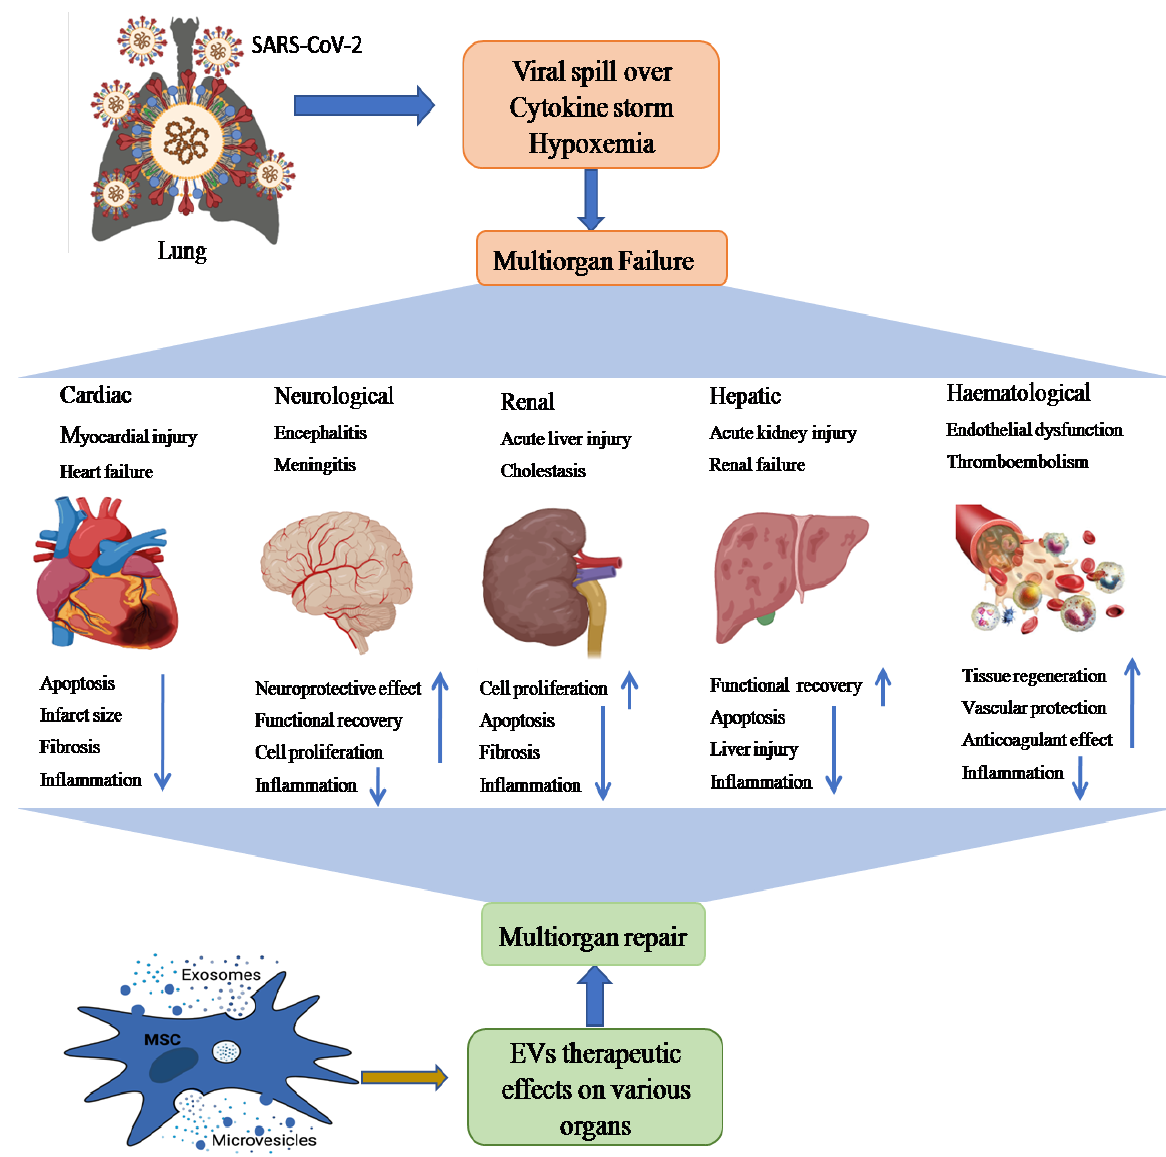
Figure 3. A schematic representation showing possible paths of MSC-EV (exosomes and microvesicles)-mediated therapy of SARS-CoV-2-induced multiple organ failure (heart, kidney, liver, brain injury, and hematological disorders). Multiple organ dysfunction mainly occurs by binding ACE2 receptors on different organs, cytokine storm, and hypoxemia. These multiorgan pathological aberrations could be recovered through anti-inflammatory, tissue regenerative, and neuroprotective effects of EVs.